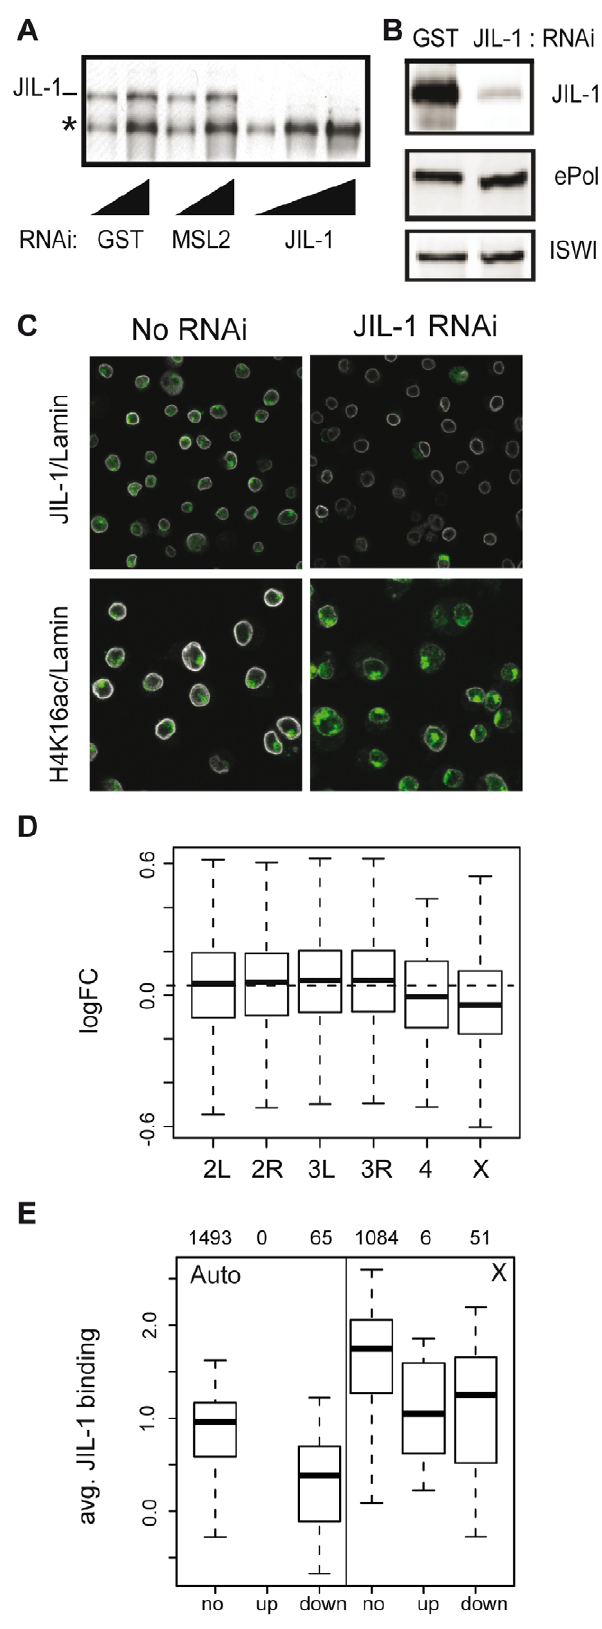
Figure 4. Effects of JIL-1 RNAi on gene expression and H4K16ac localization in SL2 cells. (A) The knock-down of JIL-1 was